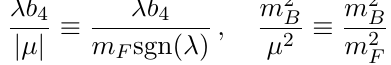
Figure 7. The m F = j (cid:22) j sgn( (cid:21) ) section of the paraboloids in (4.15) and (4.16) for j (cid:21) j < 1 of the inset pair-of-plots in (cid:12)gure (a) correspond to the pro(cid:12)les of the potential U 0 ( (cid:27) 0 ) (the plot on the left) and U ( (cid:27) ) (the plot on the right). The vertical lines in each of these plots correspond to the points (cid:27) 0 = 0 and (cid:27) = 0 respectively. The inset plots in (cid:12)gure (b) are the pro(cid:12)les of the potential (4.11) and the two vertical lines in these plots correspond to (cid:27) = (cid:0) m F = 2 (cid:21) and (cid:27) = 0 respectively. The blue lines correspond to a minimum of the local potential crossing the vertical axis while the red lines correspond to a maximum crossing the vertical axis. The dashed and dotted lines correspond to either the appearance or disappearance of new extrema in the